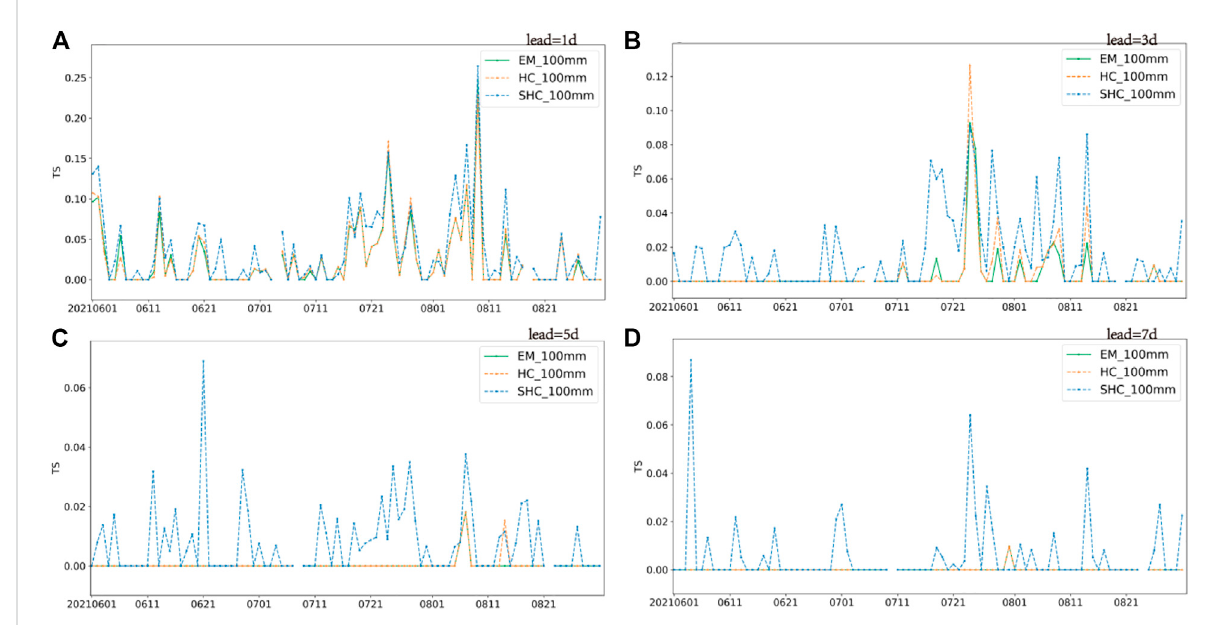
FIGURE 4 TimeseriesofTSrelatedto100mmprecipitationwithleadtimeof1 (A) ,3 (B) ,5 (C) ,and7 (D) daysinsummer2021;green,orange,andbluelines denote EM, HC, and SHC,